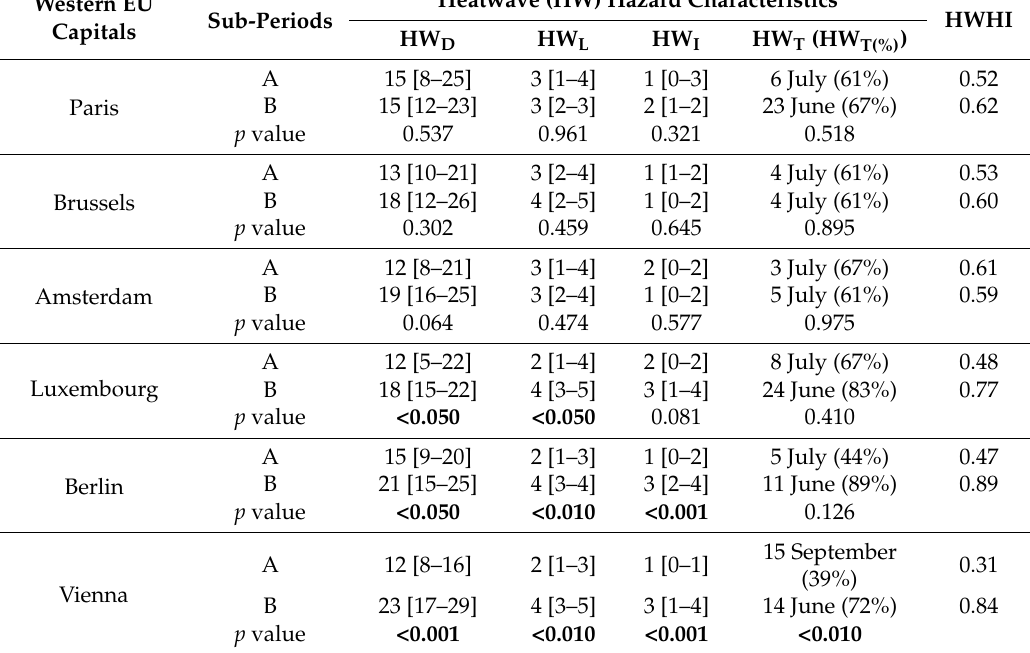
Table 6. The median of heatwave (HW) hazard characteristics (HW D : HW days; HW L : long HWs; HW I : high-intensity HWs; HW T : the timing of the first simultaneously long and high-intensity HW) and the value of the Heatwave Hazard Index (HWHI) referred to the 1980–1997 (A) and the 1998–2015 (B) 18-year sub-periods for western EU capitals. The 75th and 25th percentiles of HW D , HW L and HW I (in square brackets) and the frequency of years with at least one simultaneously long and high-intensity HW (HW T(%) in round brackets) are shown. The significance level ( p value) of associations between the two 18-year sub-periods are shown (bold when significant).